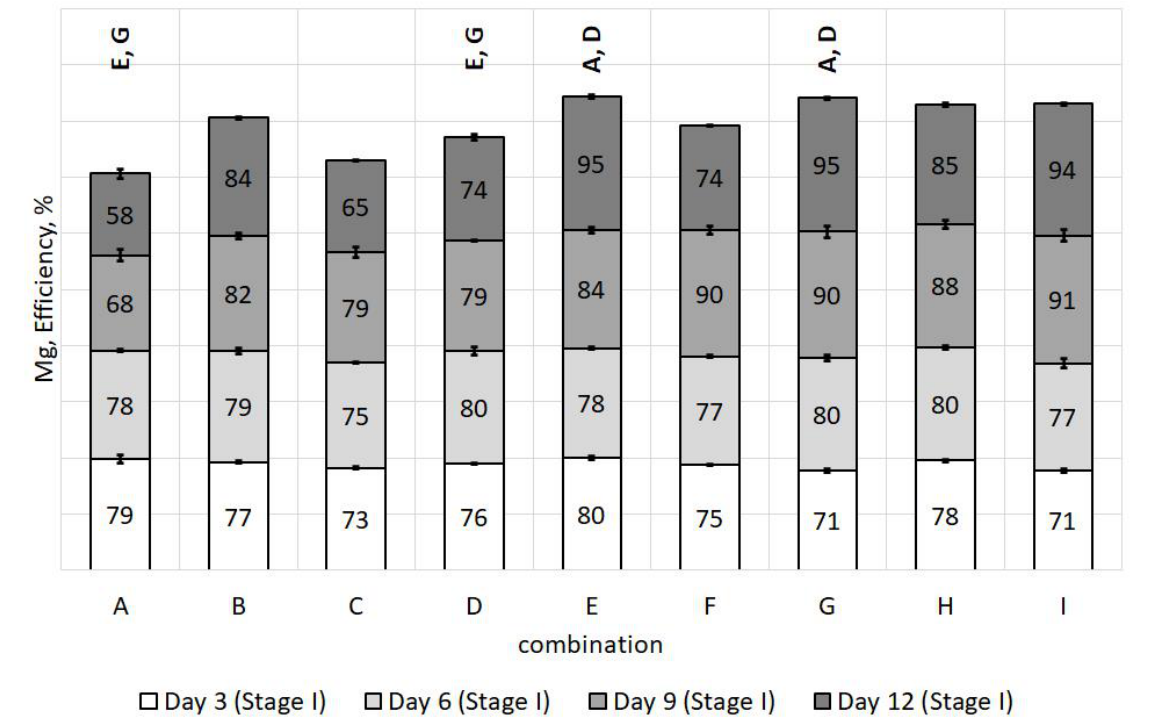
Figure 15. Effectiveness of Mg release to the dissolved fraction of leachate (Stage I).